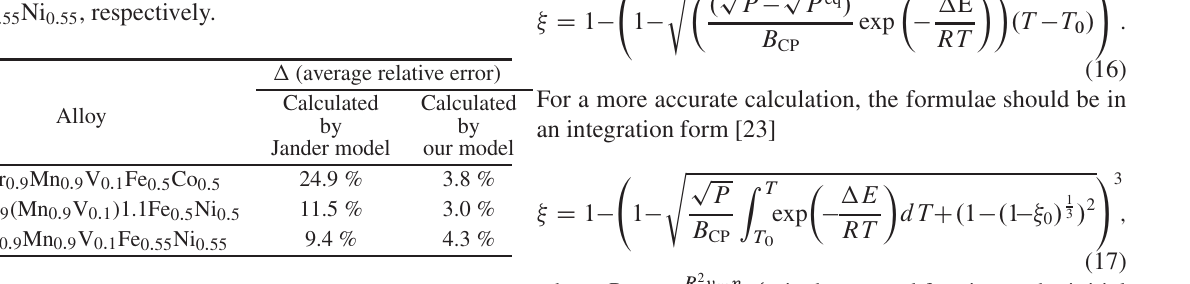
Table 2. Comparison of the calculation error from Jander model and Chou